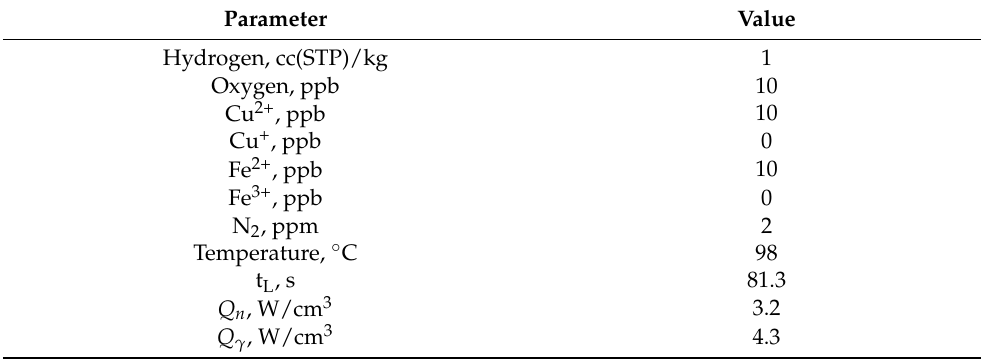
Set of parameters for the simplified model representing a single module in the radiolysis